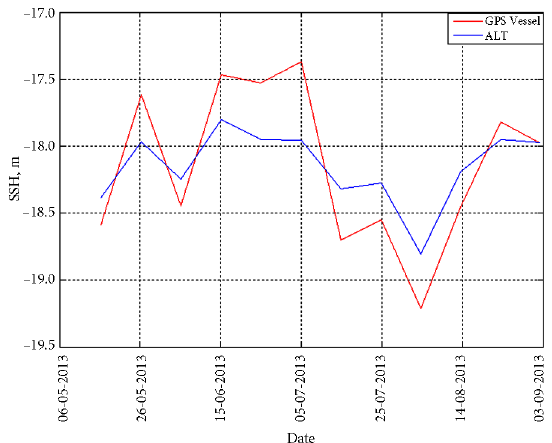
8. Sea surface heights derived by GPS vessel and satellite altimetry with RMSE of 0.256 Table 7. Main experimental features of GPS vessel employed in this study